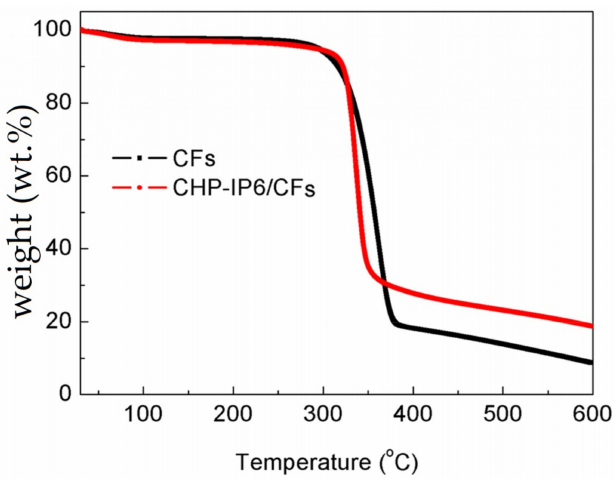
Figure 8. Thermogravimetric analysis curves of pristine cotton and coated